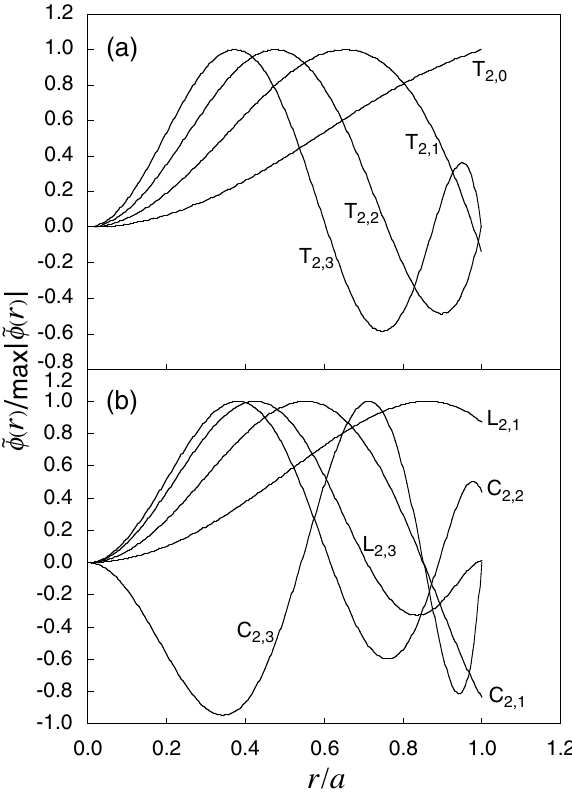
FIG. 12. Examples of the approximate radial mode structure as a function of r=a for the three classes of quadrupole modes: (a) the usual quadrupole mode T modes; (b) the high- and the low-frequency coupling modes. The case considered here is for ak (cid:3) 2 : 0 , b=a (cid:3) 1 : 5 , (cid:10) (cid:3) , and zero wall impedance. The maximal amplitude 0 : 6976 (cid:10) o is normalized to